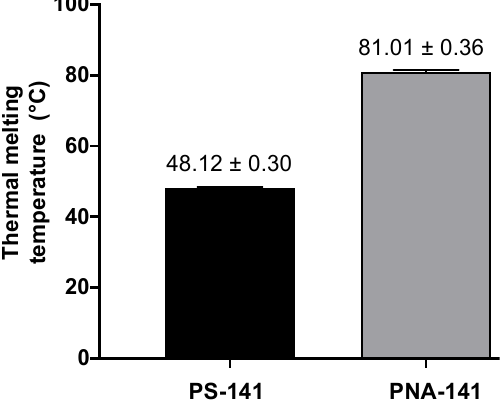
Figure 2. Thermal melting temperature (Tm) determination of PS-141-miR-141 duplex and PNA-141-miR-141 duplex by UV-Vis absorbance studies. The samples were made in simulated physiological buffers conditions. The concentration of anti-miRs and target miR-141-3p was 4 µM each. N = 3, data represented as mean ± standard error mean (SEM).